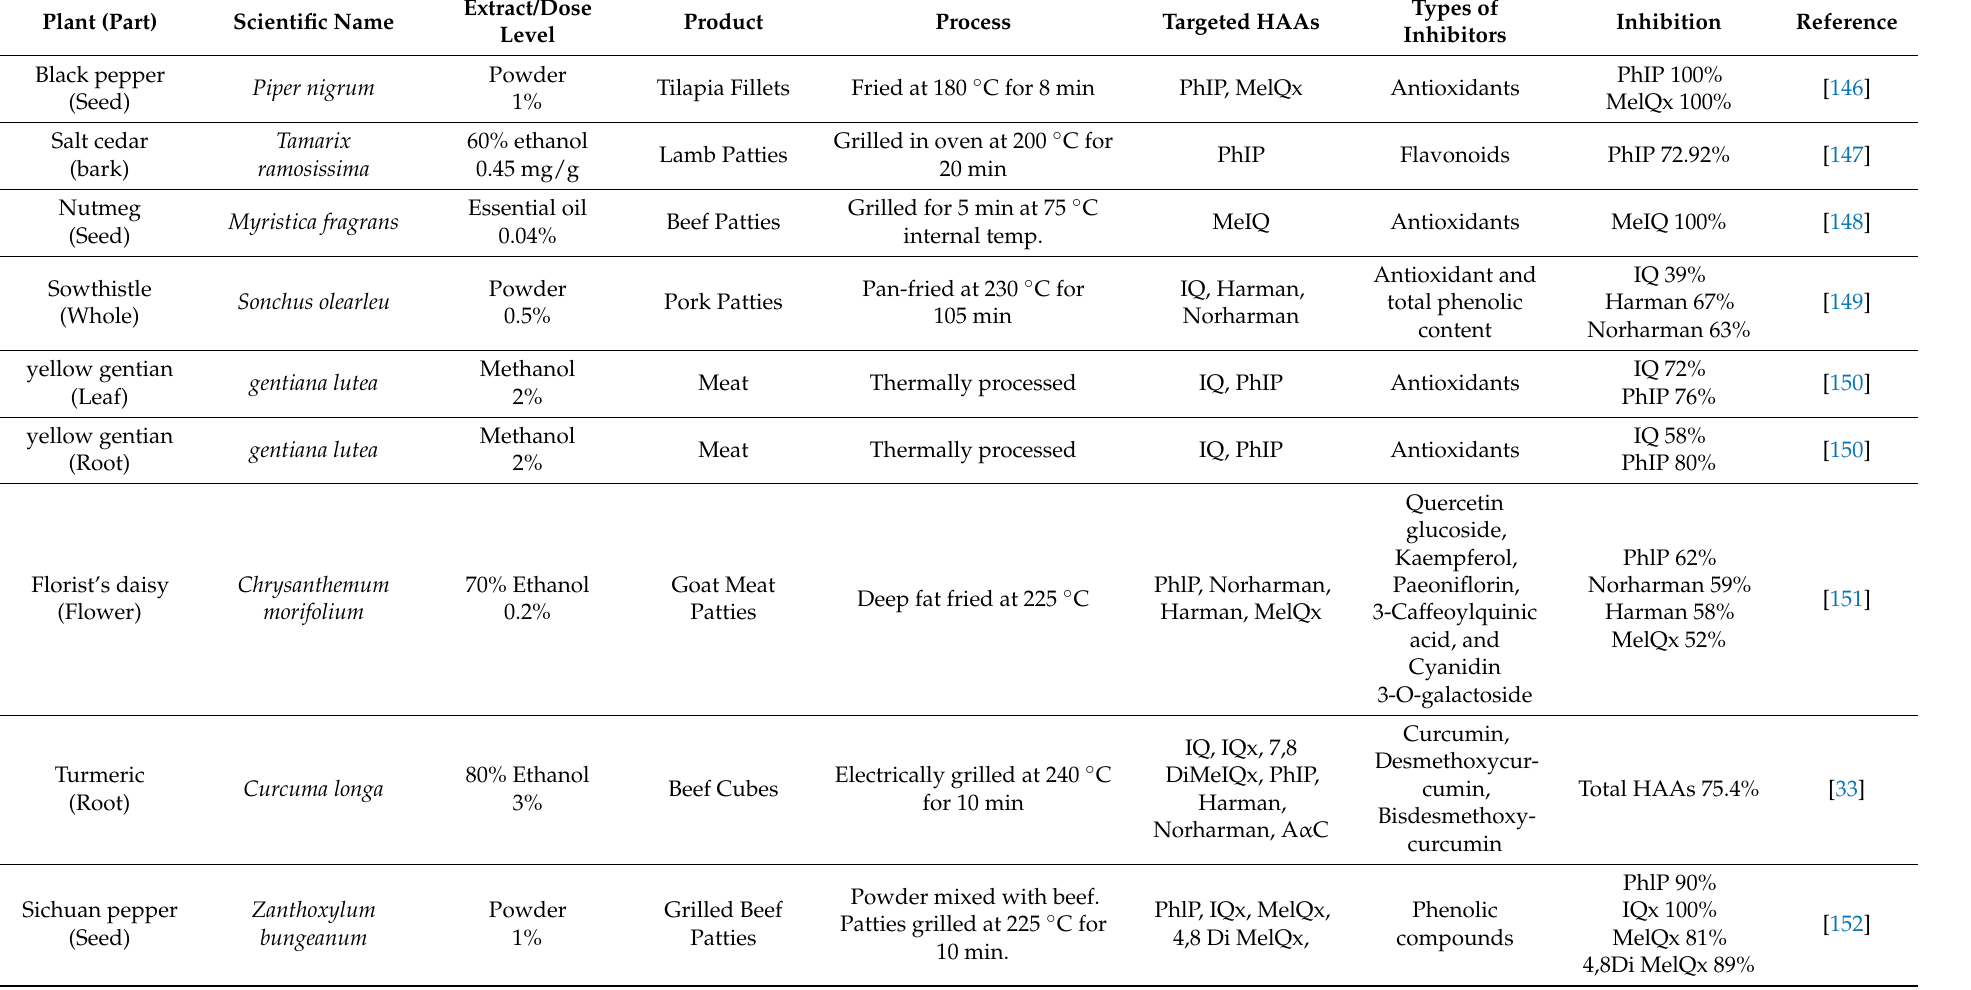
Table 2. Heterocyclic amine inhibitory effect of some